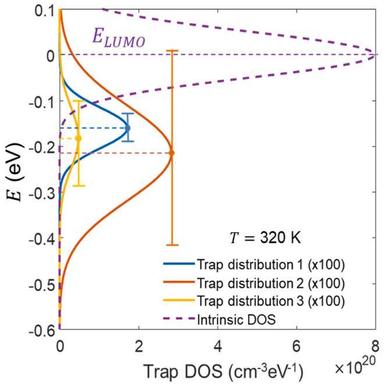
Representation of the DOS of the three trap contributions at 320 K (plain lines, note the ×100 magnification), and the intrinsic DOS (dashed purple line). The error bars represent the trap energy ranges giving an acceptable Q-DLTS spectrum fit (when varying only a given trap energy). (For interpretation of the references to colour in this figure legend, the reader is referred to the Web version of this article.)